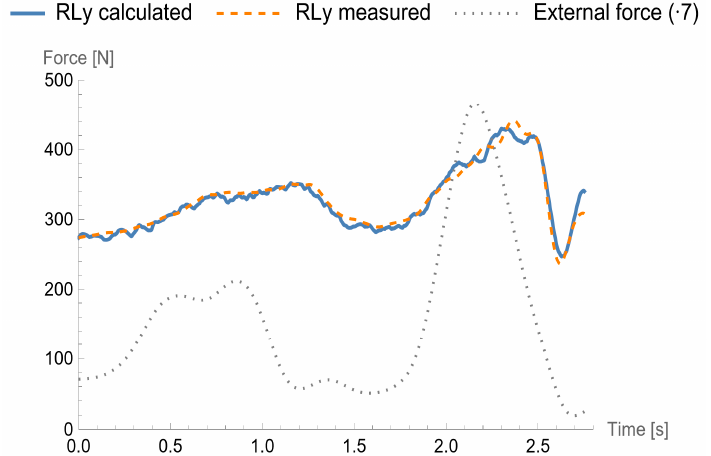
Figure 10. The vertical component, RL y , of the GRF for the left foot in the case of the external force-caused fall with two pulls. The RL y measured with the dynamometric plate is drawn using the dashed line, and the RL y calculated is drawn using the solid line. The dotted line presents the time course of the external force magnitude. The error δ = 0.0227.